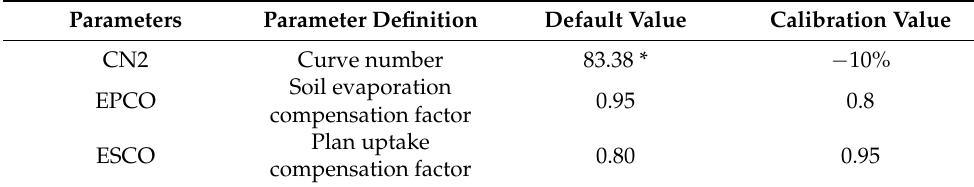
Table 1. SWAT behavioral parameters used for calibration. Parameters Parameter Definition Default